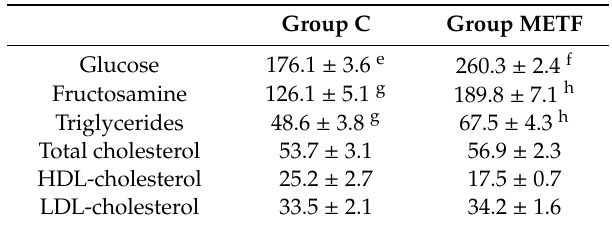
Table 3. Mean ( ± SEM) values for plasma concentrations (mg / dL) of glucose, fructosamine, and lipids (triglycerides and total-, HDL-, and LDL-cholesterol) in control (group C) and metformin-treated fetuses (group METF) at day 100 of